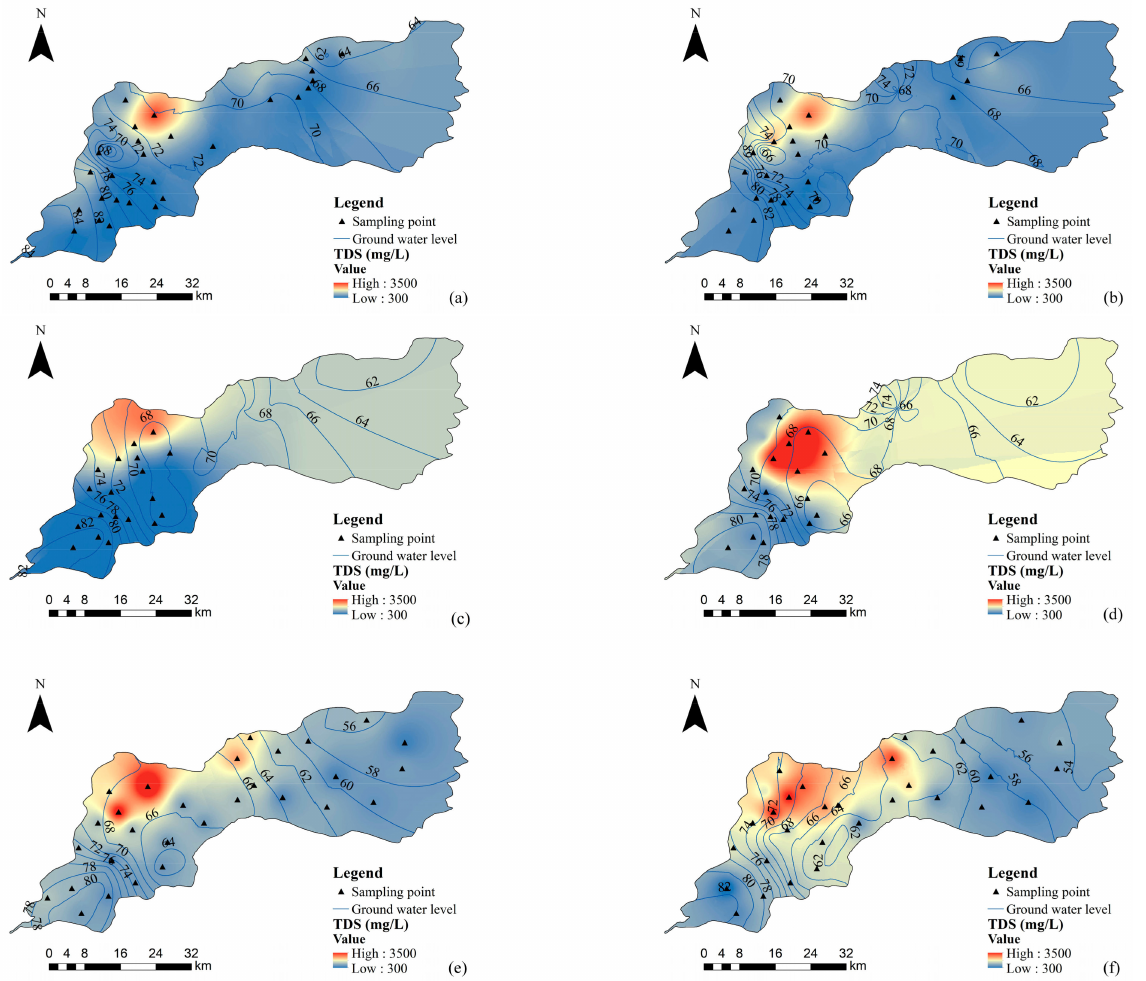
Figure 3. Spatial distribution of groundwater level (( a – f ) are 1996, 2001, 2003, 2013, 2016, and 2022,